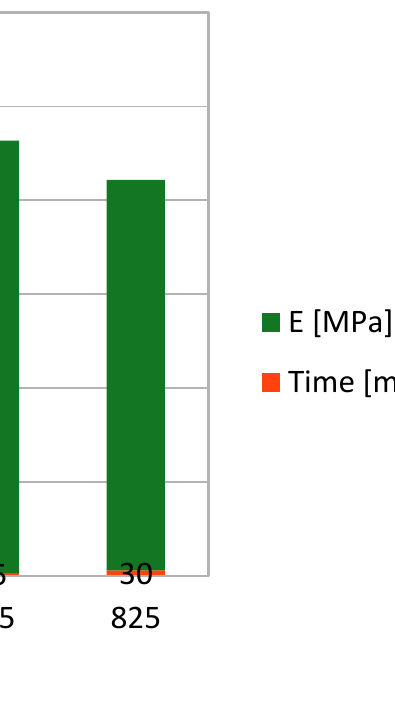
Figure 4. Compressive modulus of the sintered powder bronze samples versus sintering time and temperature. In Figure 4, each green column represents the compressive modulus obtained at various sintering temperatures (725–825 ◦ C), and each red column is the hold time of the sintering